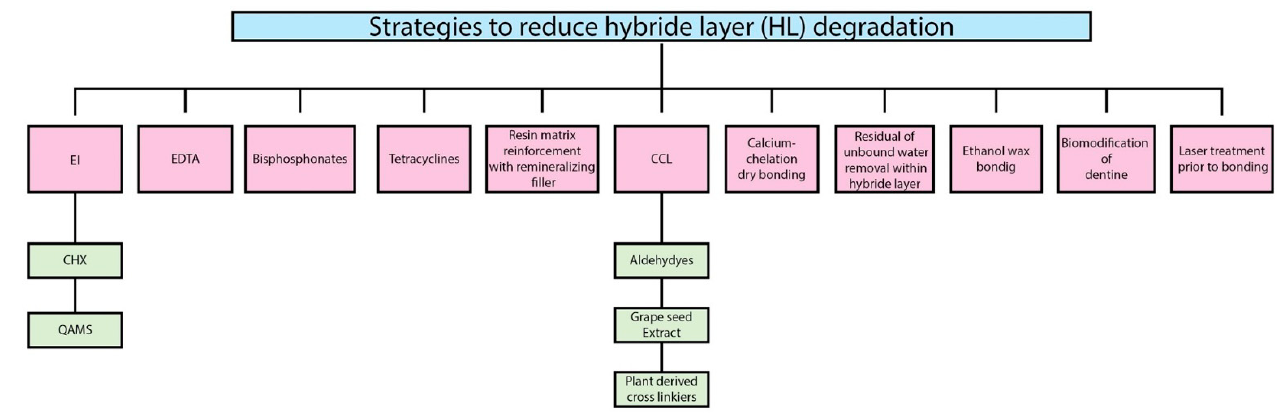
Figure 1. Summary of the strategies used to reduce hybrid layer degradation. EI → Enzymes Inhibitors; CHX → Chlorhexidine; QAMS → Quaternary ammonium methacrylate compounds; EDTA → Ethylene diamine tetra acetic acid (EDTA); CCL → Collagen Cross Linkers.